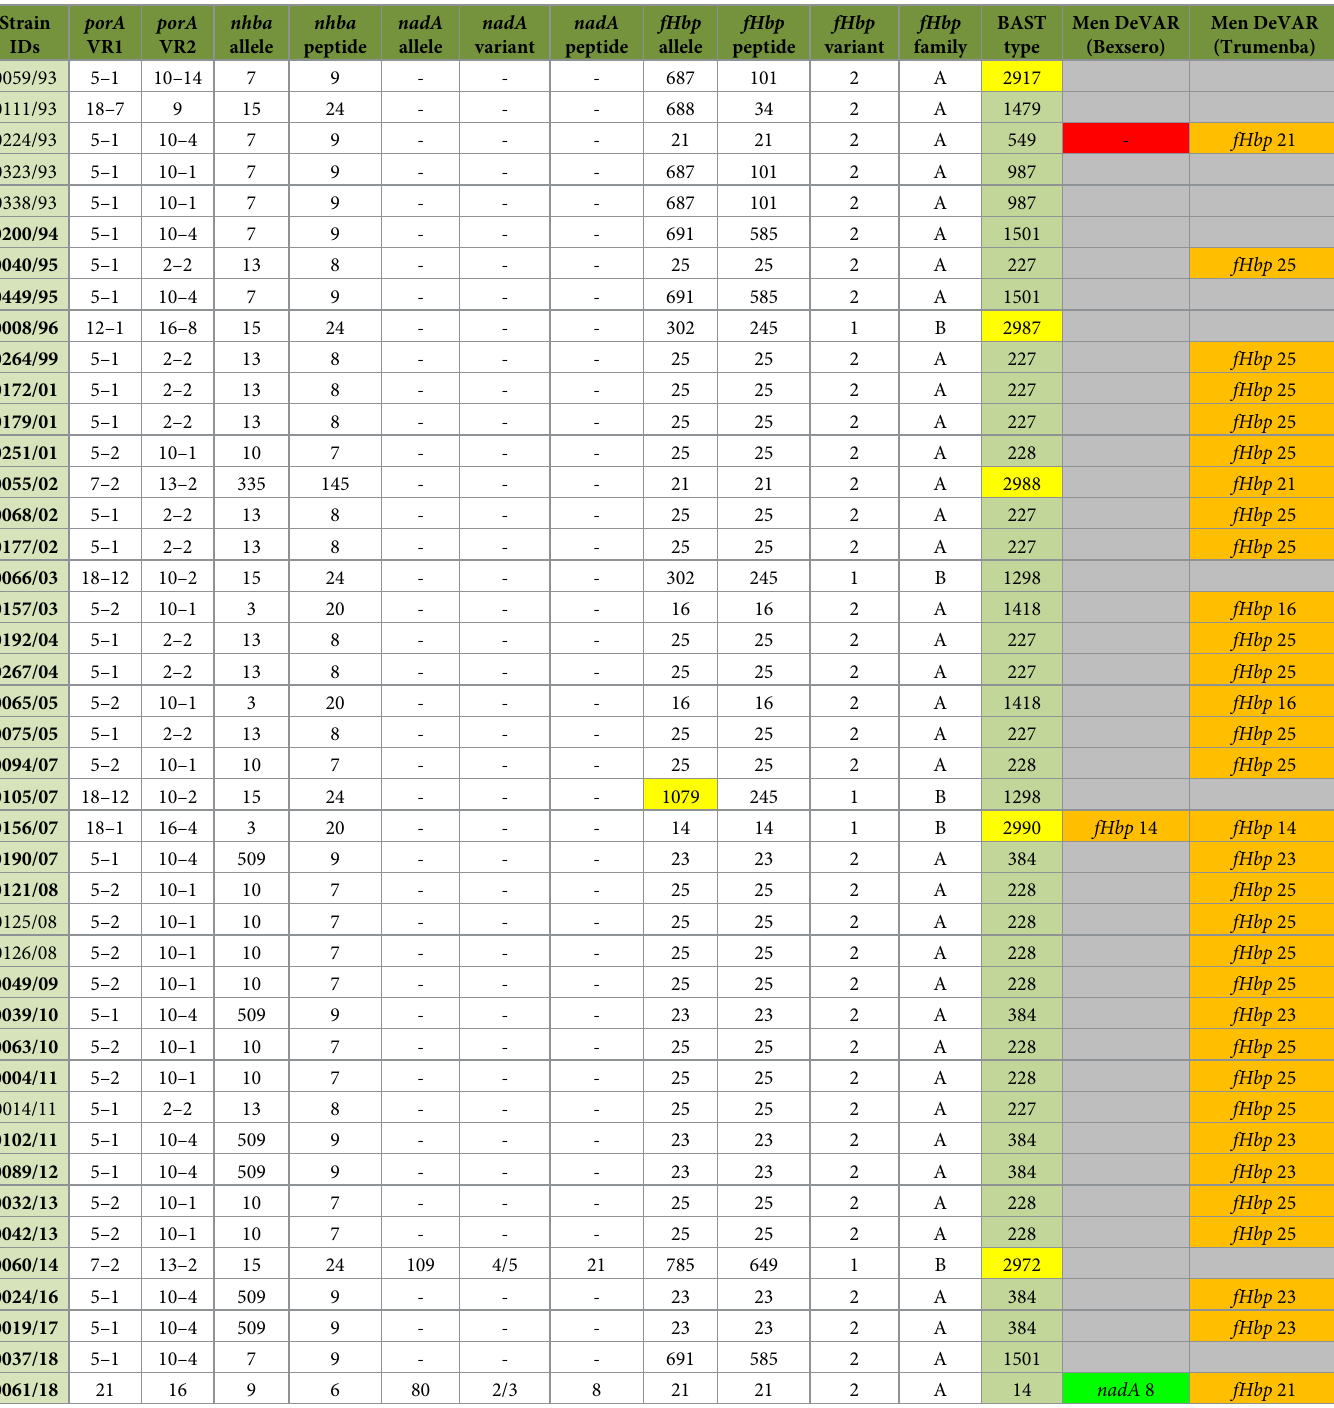
Table 2. Molecular characterization focused on MenB vaccine antigens of N . meningitidis Y isolates collected in the Czech Republic from 1993 to 2018, (n = 43).